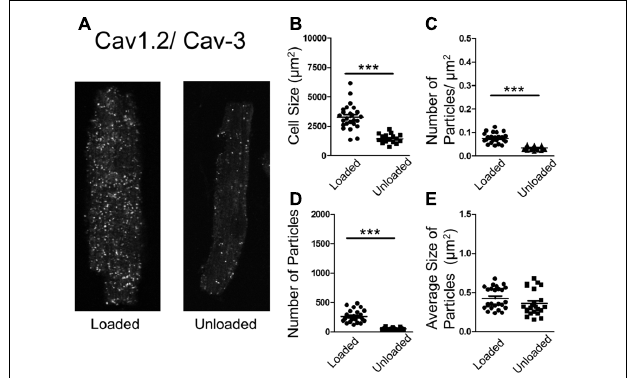
FIGURE 5 | (A) PLA image demonstrating the association of Cav1.2 and Cav-3 in loaded and unloaded cells. (B) Graph comparing the size of loaded and unloaded cells (loaded 3271 ± 212.4 µ m 2 vs. unloaded 1444 ± 92.03 µ m 2 N,n 3/17-25 mean ± SEM ∗∗∗ p < 0.001). (C) Graph comparing the number of particles/ µ m 2 in loaded and unloaded cells (loaded 0.076 ± 0.0042 particles/ µ m 2 vs. unloaded 0.034 ± 0.0016 particles/ µ m 2 N,n 3/23-25 mean ± SEM ∗∗∗ p < 0.001). (D) Graph comparing the number of particles in loaded and unloaded cells (loaded 261.9 ± 20.61 vs. unloaded 50.52 ± 3.70 N,n 3/23-25 mean ± SEM ∗∗∗ p < 0.001). (E) Graph comparing the average size of particles in loaded and unloaded cells (loaded 0.425 ± 0.028 µ m 2 vs. unloaded 0.361 ± 0.03 µ m 2 3/23-25 N,n mean ± SEM NS).